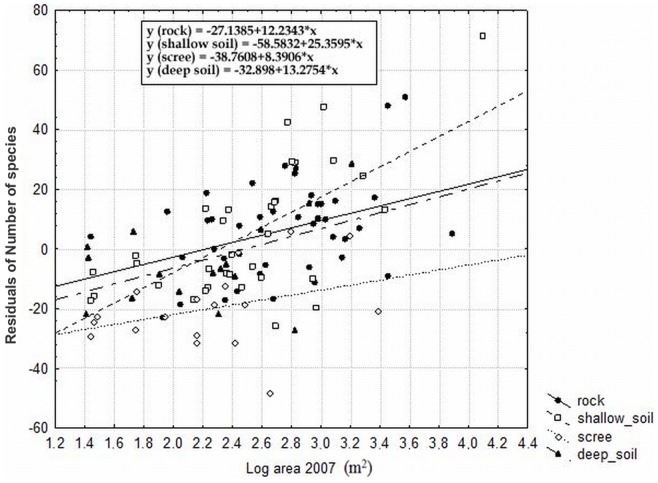
The effect of current area and prevailing type of substrate on species richness.(depicted as residuals of number of species with coordinates as covariates). P<0.0001; r = 0.533 for area and p = 0.0004; r = 0.367 for type of substrate.